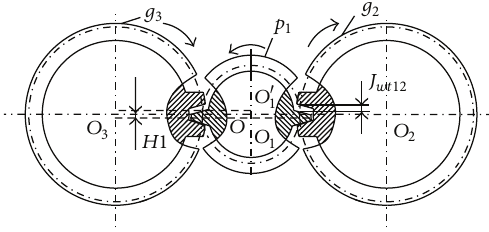
Figure 11: Closed movement relationship.